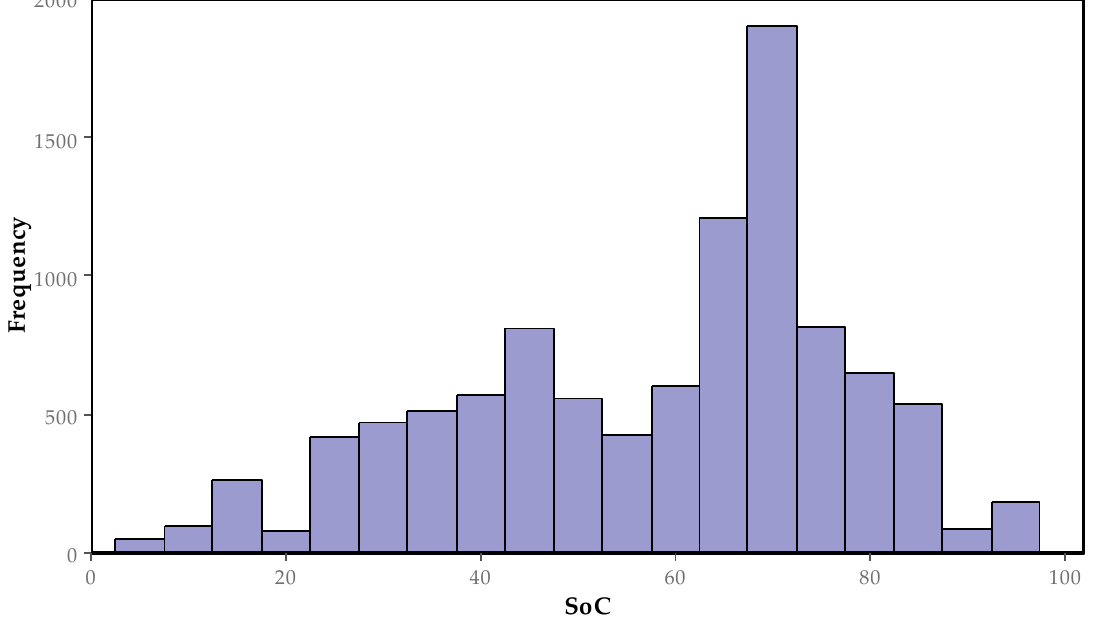
Figure 5. Histogram of the EV initial SoC reported by the data analyzed.